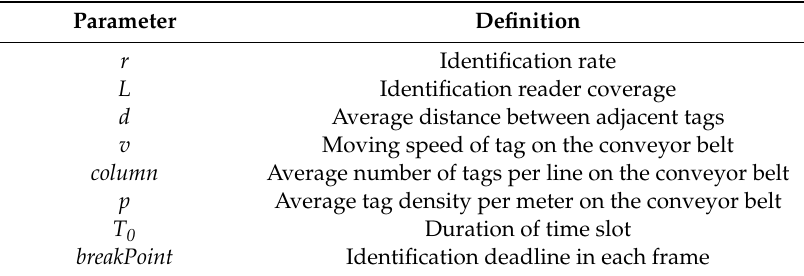
Table 2. Definition of parameters in the simulated